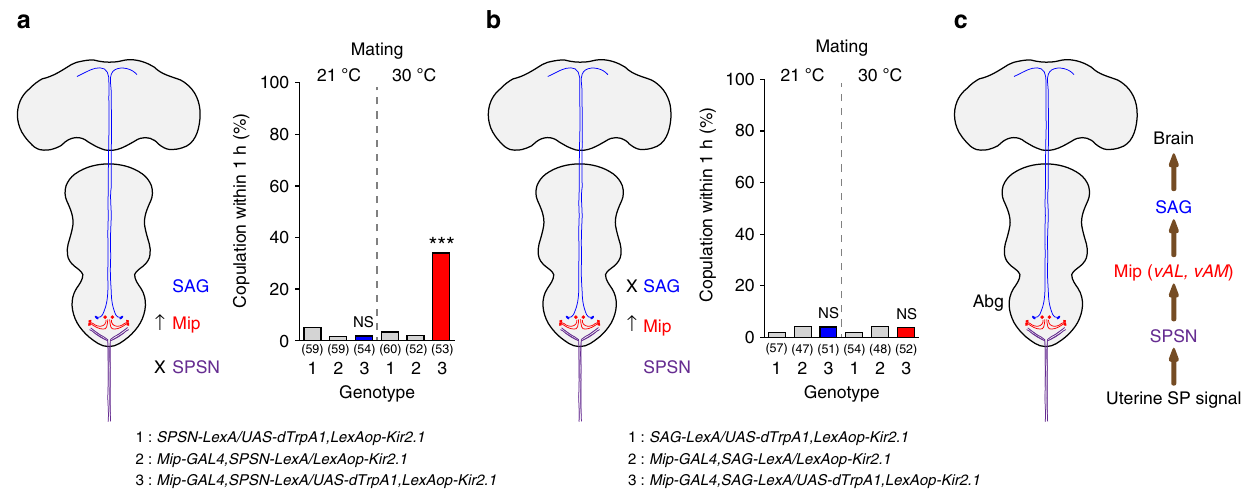
Fig. 6 Mip neurons positioned within the SPSN and SAG signalling axis. a , b Mating frequencies of virgin females of the indicated genotypes, scored as the percentage of females that copulate within 1 h. The numbers in parentheses indicate n . NS indicates non-signi fi cance ( P > 0.05); *** P < 0.001 for comparisons against both controls (grey bars); Chi-square test a , b . c Model explaining the hierarchical relationships of the various components of the AG circuits that control female receptivity (for details, see the